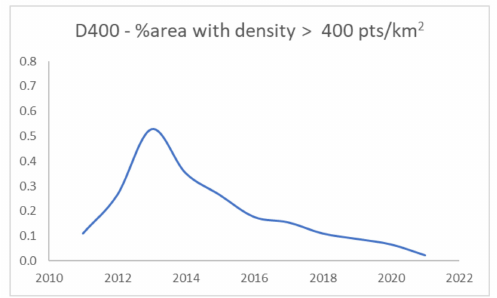
Figure 19. Trend of the percent of areas with density points greater than 400 pts/km 2 for shoplifting in the Liverpool Street